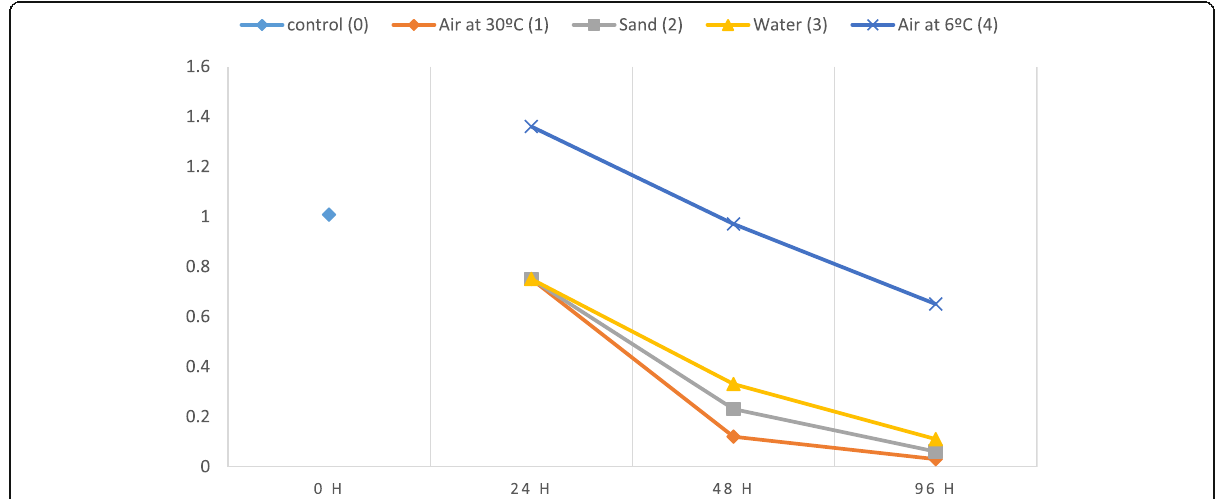
Fig. 1 GAPDH mean expression values in brain of different groups at different time intervals. The description of brain GAPDH mRNA mean expression values of different groups at different time intervals showed that the highest expression values were represented at the 0-time (control group) and the lowest values at 96 h with an exception in group 4 that showed higher expression level at 24 h relative to the